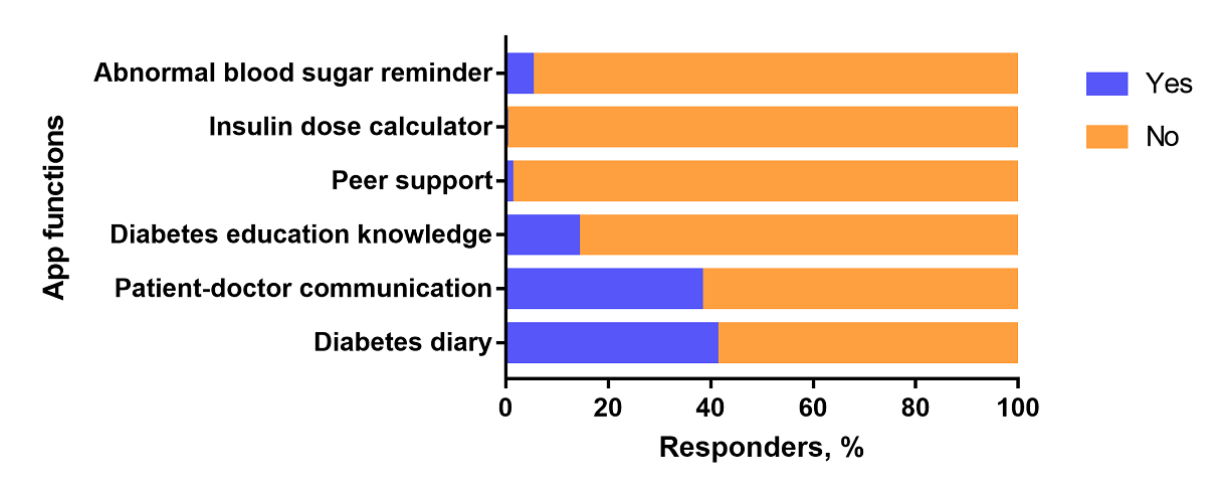
Figure 4. Diabetes app functions considered to be most important by diabetologists